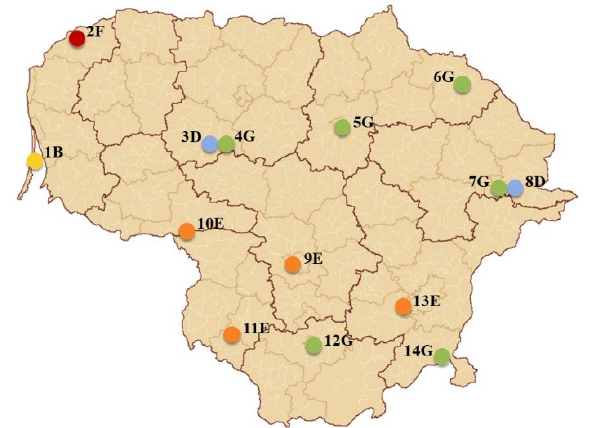
Figure 6. Sampling sites with common juniper ( Juniperus communis ) (Lithuania). 1–14—sites; habitat types: B—coastal brown dunes covered with natural Scots pine forests, F— Juniperus communis scrubs, D—transition mires and quaking bogs, G—subcontinental moss Scots pine forests, E—xero- thermophile fringes.